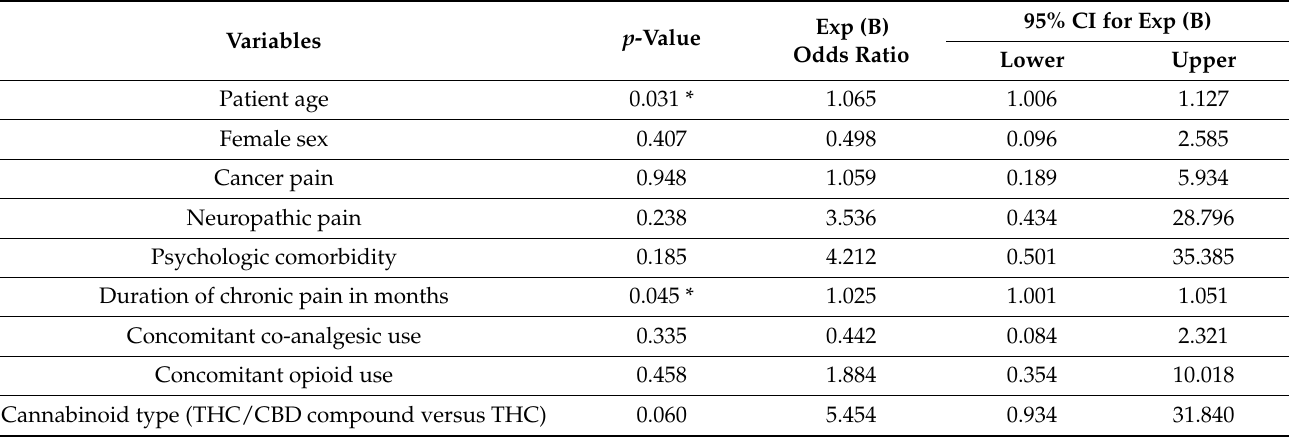
Table 3. Multivariate logistic regression analysis of the association between at least a 30% reduction in mean pain intensity and cofactors under cannabinoids.